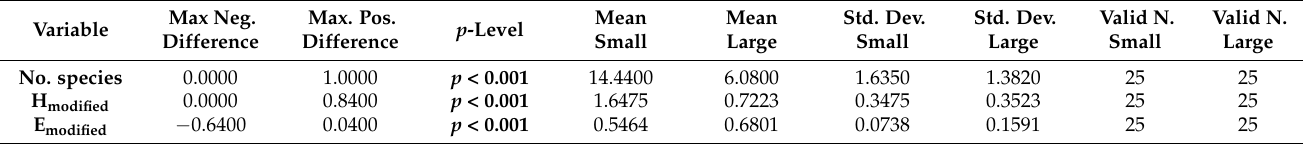
Table 4. Results of non-parametric Kolmogorov–Smirnov test between small and large SWEs.